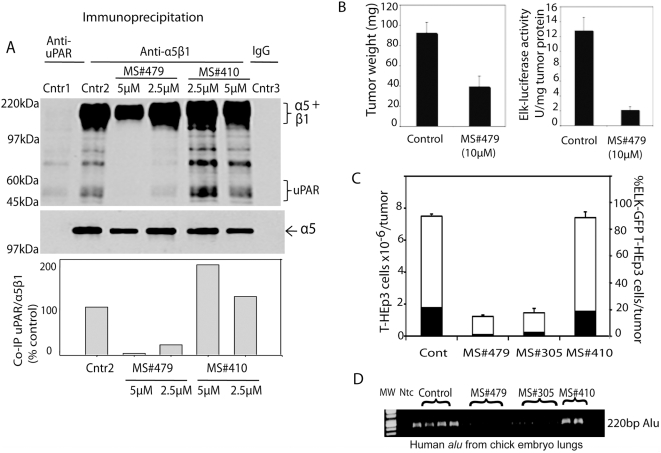
Lead compounds inhibit tumor growth and metastasis through uPAR/integrin disruption and ERK inhibition.A. Disruption of physical interaction between uPAR and α5β1-integrin. Confluent T-HEp3 cells were surface biotinylated, lysed and incubated with Domain I anti-uPAR antibodies R3 (Cntr1), anti-α5β1-integrin antibody (HA5), or with isotype matched IgG, (Cntr 3). After 1 hr the precipitates were treated for 15 min with 2.5 or 5.0 µM of compound MS#479 or MS#410 and the proteins analyzed by Western blotting using Neutravidin-HRP conjugate for detection. Bottom panel; top portion of the upper blot was re-probed, after stripping, with anti-α5 integrin antibody. α5-integrin and uPAR were scanned and quantified using Image J and the ratio of uPAR to integrin was determined. The bars represent the ratio expressed as percent of control. This experiment was performed 3 times. B. In vivo treatment of T-HEp3 cells with compound MS#479 inhibits ERK activity and tumor growth. T-HEp3 cells stably transfected with ELK-luciferase (as in Fig. 1C) were mixed with 10 µM of compound MS#479 in DMSO or DMSO (0.1%) and inoculated on CAMs of 10 day old chick embryos at 4×105 cells/CAM, 4 CAMs per group. The tumors were treated daily with 30 µl of 10 µM MS#479 or 30 µl of 0.1% DMSO for 6 days, at which time the tumors were excised, weighed, lysed and Luciferase activity was determined as described in Methods. The inhibition by compound #479 was statistically significant (n = 7/group, tumor weight, p<0.0001, Luciferase, p<0.0001, t-test). C. The effect of MS#479, MS#305 and MS#410 (negative control) on tumor growth and ERK inhibition measured by ELK-GFP expression. T-HEP3 cells stably transfected with ELK-GFP construct were treated with the 3 compounds or DMSO as in B but 5×105 were inoculated and, at the end of the incubation, single cell suspensions of tumors were prepared and total as well as GFP-expressing cell number was determined for each tumor. The graph shows the total number of tumor cells per tumor (mean, n = 5, white bars) and percent of GFP-positive cells (darkened part of bars). Both compounds significantly (ANOVA p<0.0001) inhibit tumor growth. MS#410 has no effect. D. The effect of compounds on spontaneous metastasis. To quantify metastases, lungs were removed from chick embryos in experiment described in Fig. 3C, DNA was extracted and used to amplify a 220 bp fragment of human alu sequence as previously described [21]. One of the MS#410 treated embryos was dead and 1 showed toxic effects.